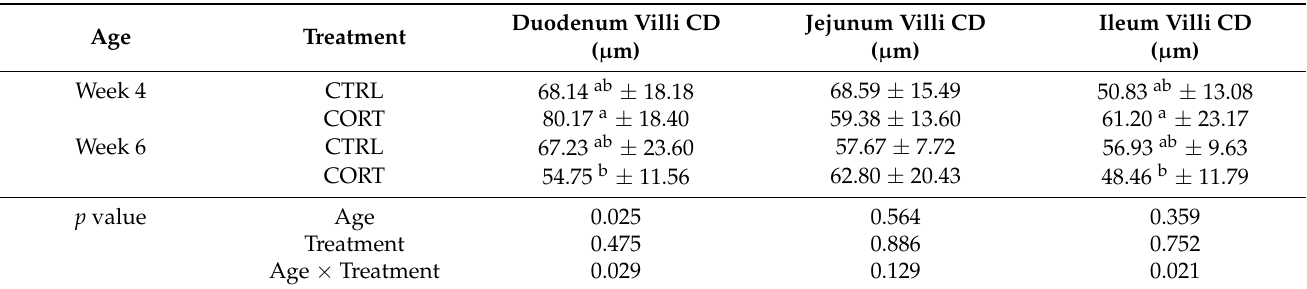
Table 5. Effect of corticosterone administration and age on duodenum, jejunum, and ileum villi crypt depth ( ± SD) of broiler chickens.